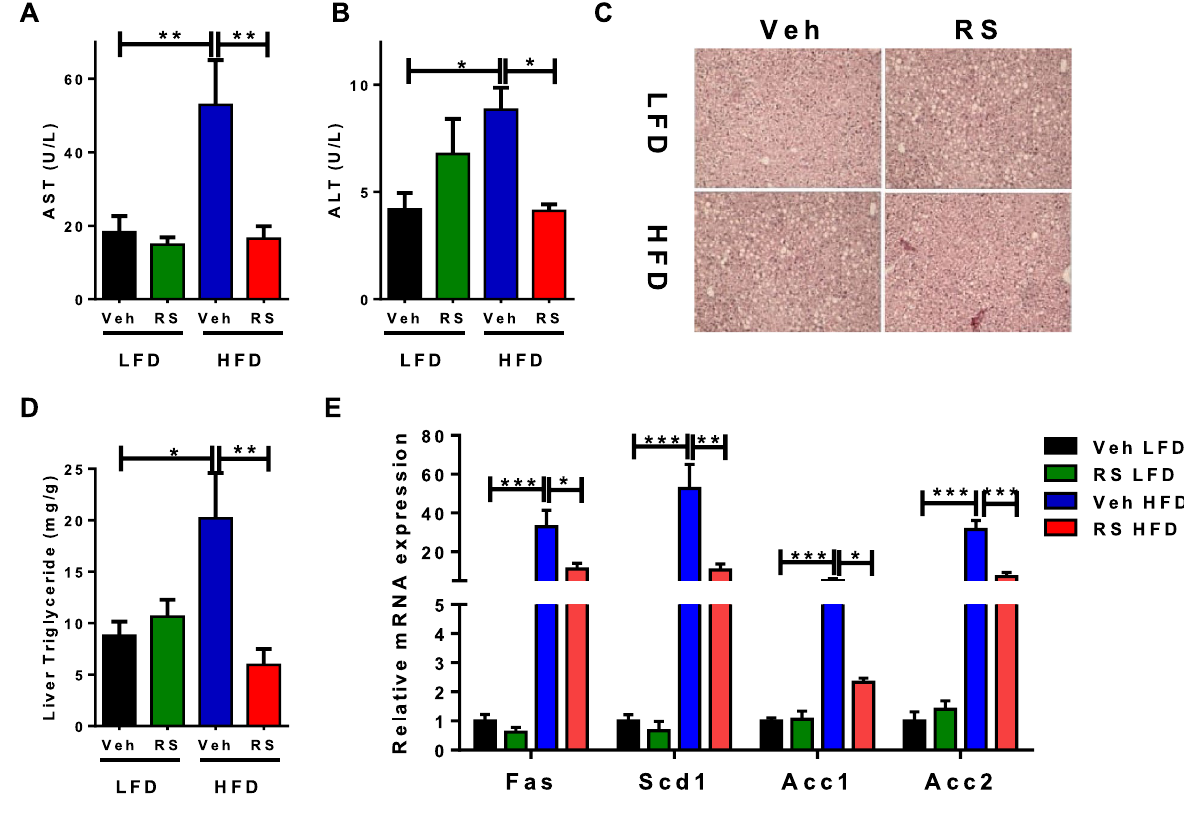
Figure 2. Roscovitine treatment prevents hepatic steatosis. ( A ) Serum level of aspartate aminotransferase (AST) in 19–20 weeks LFD and HFD fed male mice treated for 6 weeks with roscovitine or vehicle (n = 5). ( B ) Serum level of Alanine aminotransferase in 19–20 weeks LFD and HFD fed male mice treated for 6 weeks with roscovitine or vehicle (n = 5). ( C ) Representative pictures of H&E-stained liver cross sections in 19–20 weeks LFD and HFD fed male mice treated for 6 weeks with roscovitine or vehicle. ( D ) Fasting liver triglyceride levels in 19–20 weeks LFD and HFD fed mice treated for 6 weeks with roscovitine or vehicle (n = 5/group). ( E ) mRNA expression level of lipogenic genes in 19–20 weeks LFD and HFD fed male mice treated for 6 weeks with roscovitine or vehicle (n = 5 / group). Data were analyzed and illustrated using GraphPad Prism 6.0 software (GraphPad, https:// www. graph pad. com). All values are expressed as means ± SEM; *p < 0.05, **p < 0.01, and ***p <